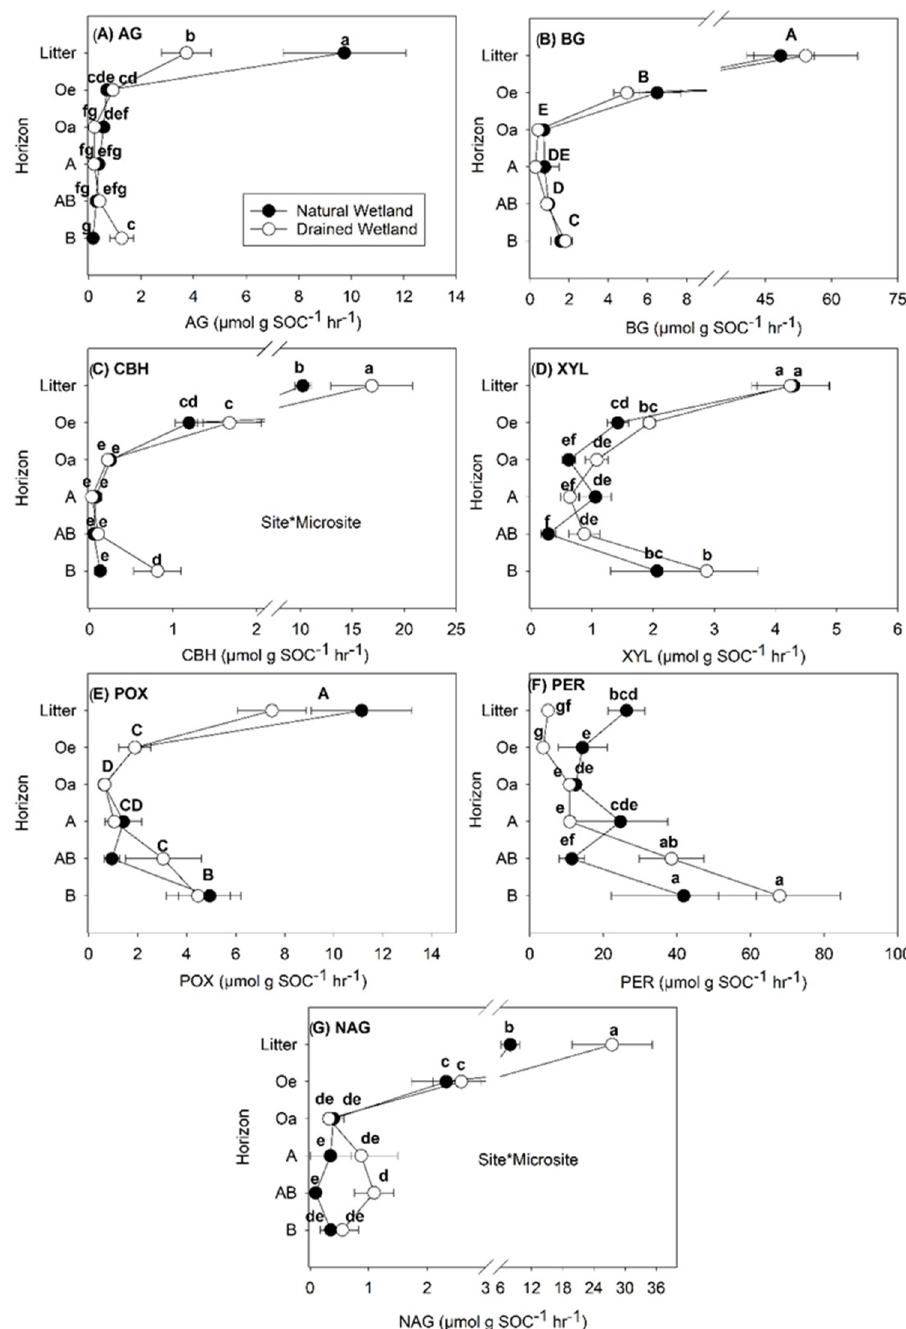
Figure 2. Specific enzyme activity rates calculated per unit mass of soil organic carbon (SOC) ( µ mol g SOC − 1 h − 1 ) in soils collected from different soil horizons within a natural and managed freshwater forested wetland. Activity of seven enzymes were measured: ( A ) α -glucosidase (AG), ( B ) β -glucosidase (BG), ( C ) cellobiohydrolase (CBH), ( D ) xylosidase (XYL), ( E ) phenol oxidase (POX), ( F ) peroxidase (PER) and ( G ) N-acetyl glucosamide (NAG). Values are means with standard error ( n = 5) and averaged across microsite, depicting the site by horizon interaction found for most enzymes assayed. Lowercase letters represent significant differences ( p < 0.05) between each site and horizon when a significant site by soil horizon interaction was found. Uppercase letters represent significant differences between soil horizons when a soil horizon main effect only was